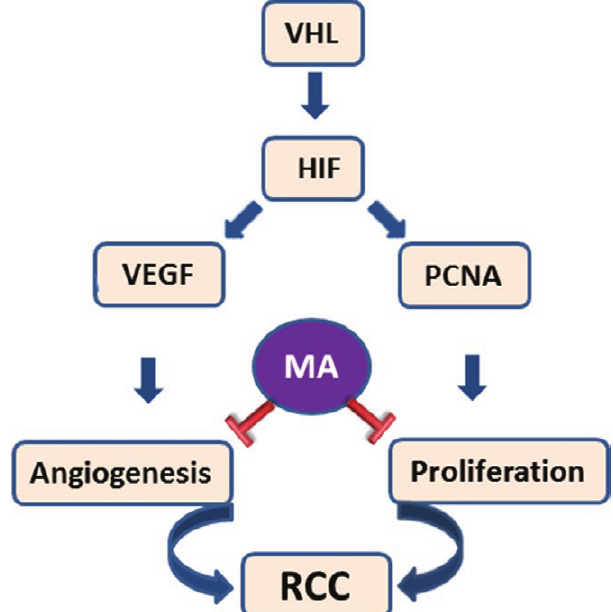
Figure 6. Putative role of maslinic acid on proliferation and angiogenesis. Aberrations of von Hippel-Lindau gene (VHL) are the major risk factors for RCC. Inactivated VHL leads to the upregulation of hypoxia-inducible factor (HIF), which in turn leads to the upregulation of many molecules that promote RCC progression through enhanced angiogenesis and proliferation. Maslinic acid inhibits angiogenesis and proliferation possibly via the downregulation of VEGF in vascular endothelial cells and PCNA in RCC. Emphasis is given to molecules of interest from this